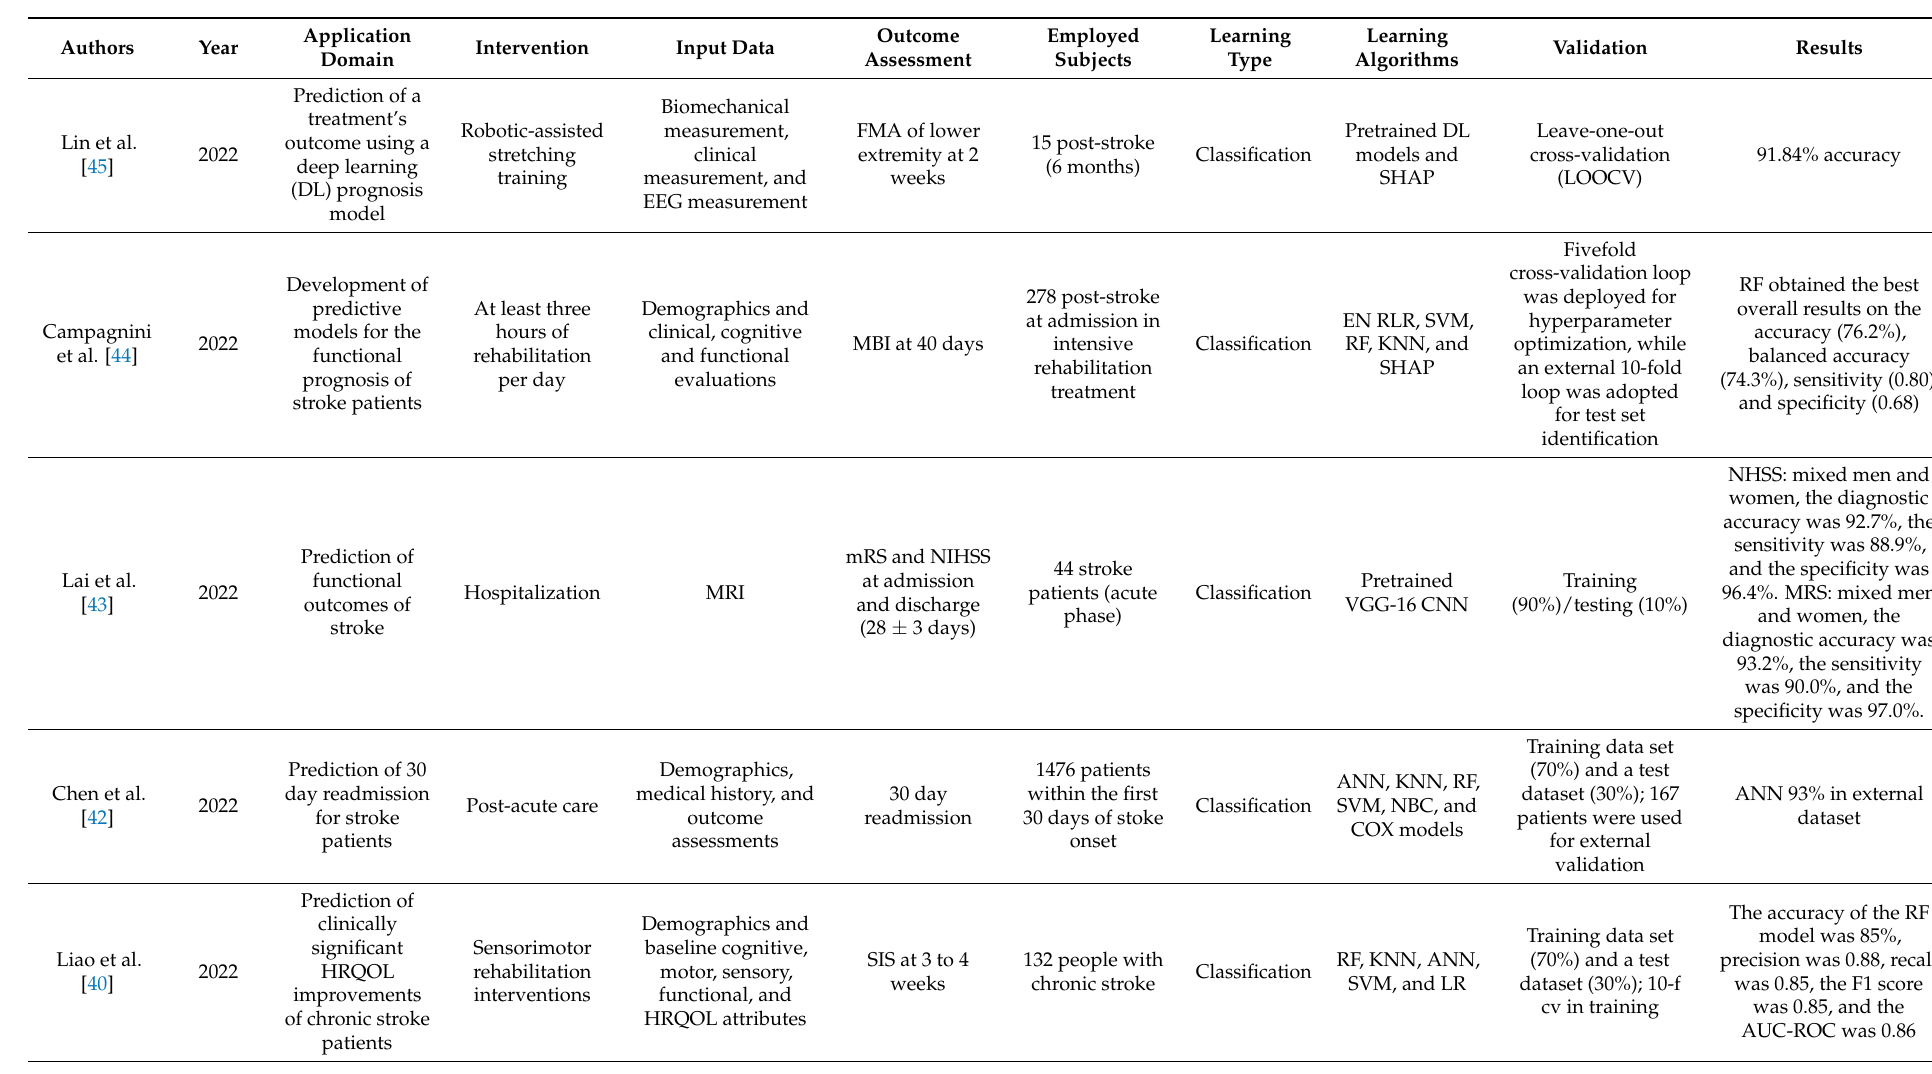
Table 1. Findings and characteristics of included ML studies for motor function